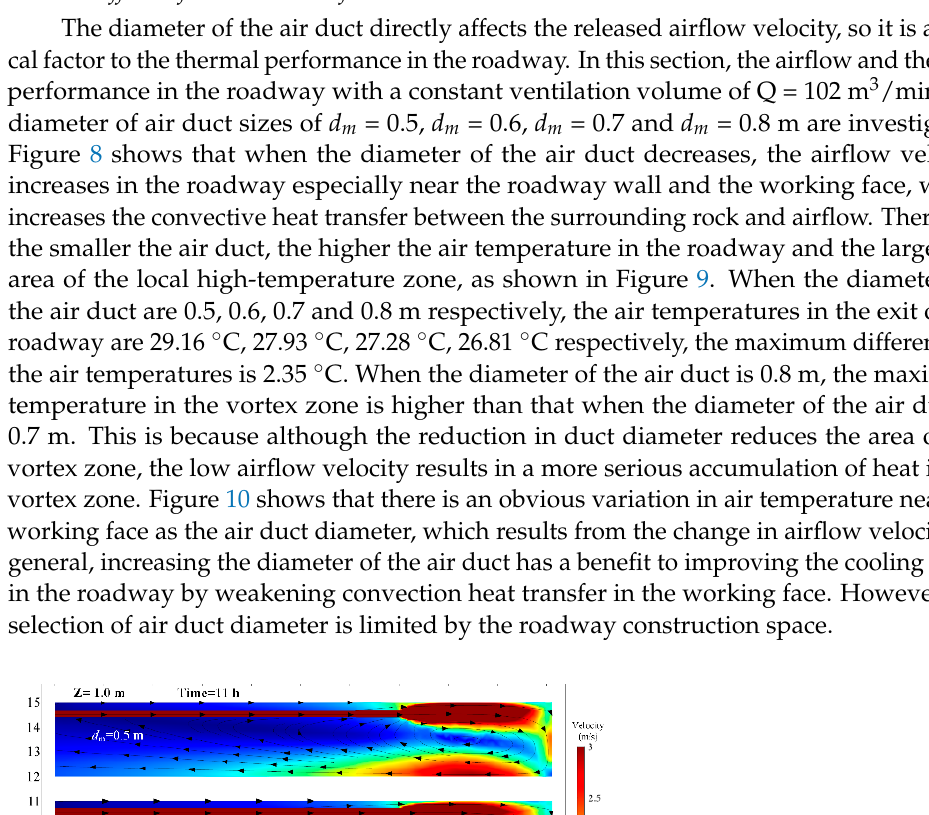
Figure 7. Air temperature in central axis of roadway ( Z = 0.5 m) for different times.